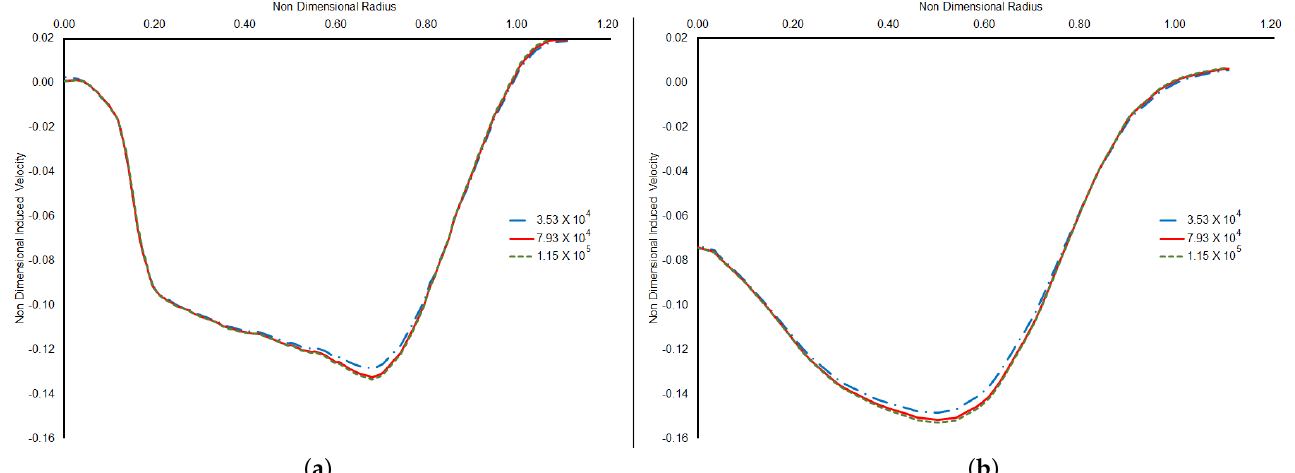
Figure 18. Comparison between induced velocity for different rotational velocities. ( a ) At 0.1R below the rotor, ( b ) 0.5R below the